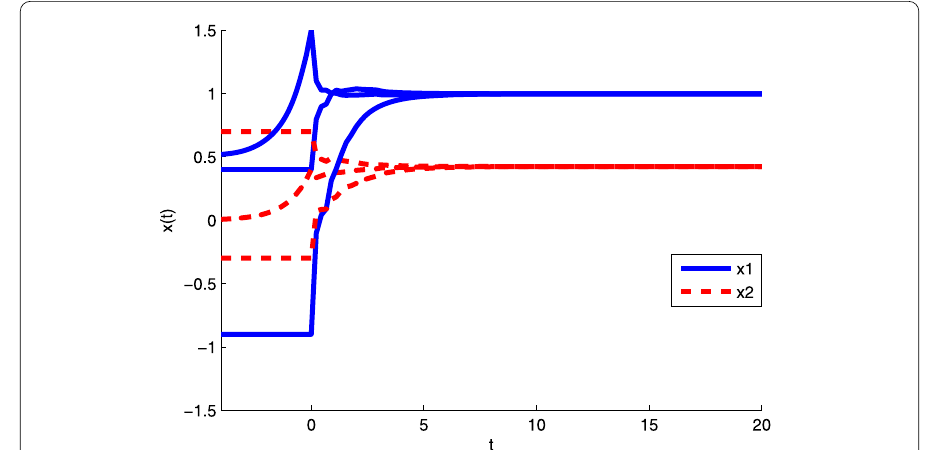
Figure 2 State trajectories of model (46) under three other initial conditions